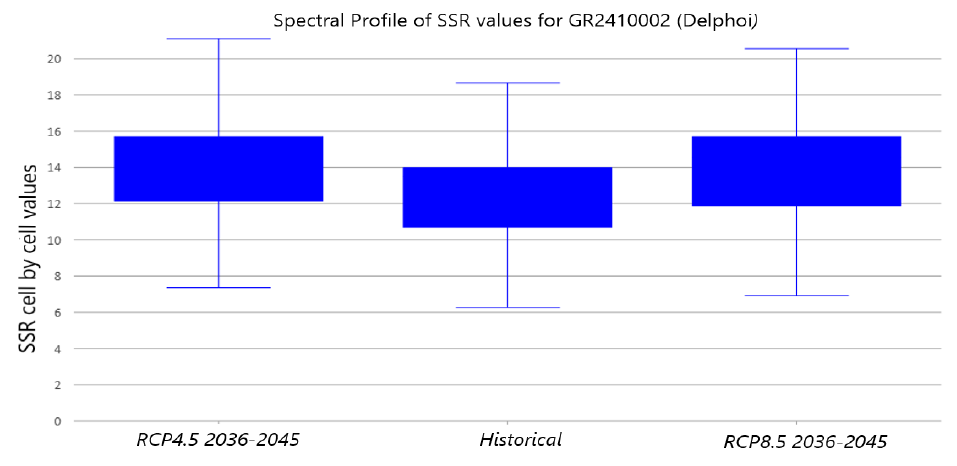
Figure 5. Spectral Profile of Seasonal Severity Rating (SSR) values for GR2410002 (Delphoi), for: RCP 4.5 2036–2045 ( left ), historic period ( centre ), and RCP 8.5 2036–2045 ( right ).